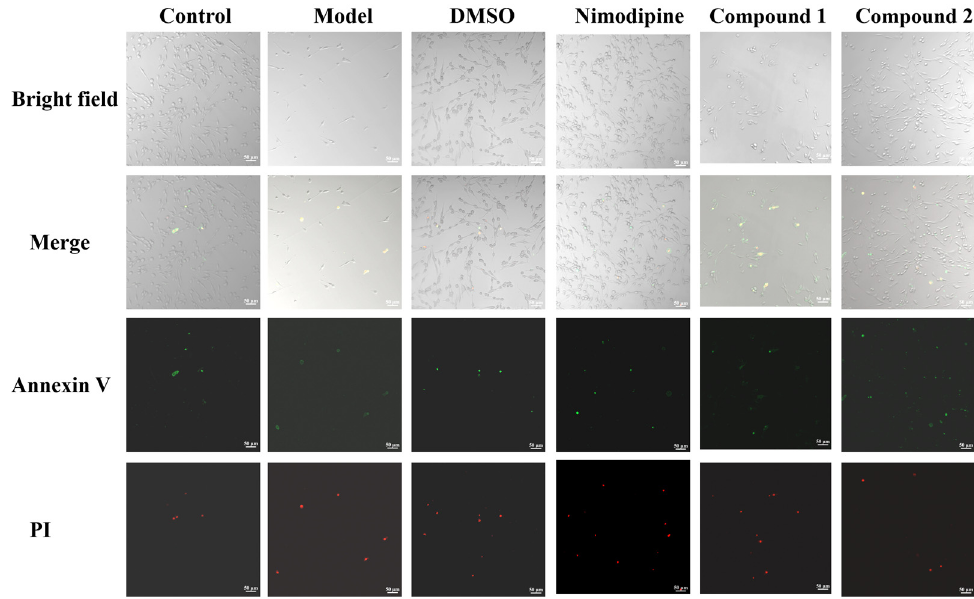
Figure 7. Annexin V-FITC/PI staining and fluorescence microscopy images (original magnification, 200 × ) (PC12 cells treated with 1 µ mol L − 1 of compounds 1 and 2 ).